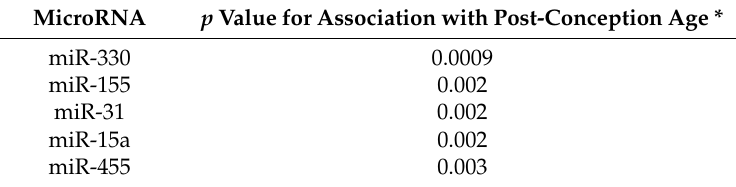
Table 2. Di ff erential expression of microRNAs by post-conception age.